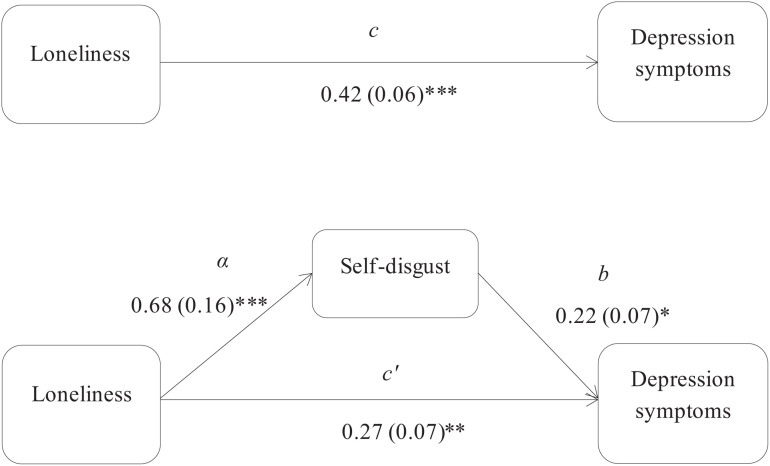
Self-disgust mediates the association between loneliness and depression symptoms in the non-PTSD group. Note: The total (c) and the indirect effect (c’) of loneliness on depression symptoms are shown. Unstandardized path coefficients are presented, with standard errors in brackets. ∗p ≤ 0.05; ∗∗p ≤ 0.005; ∗∗∗p ≤ 0.001.